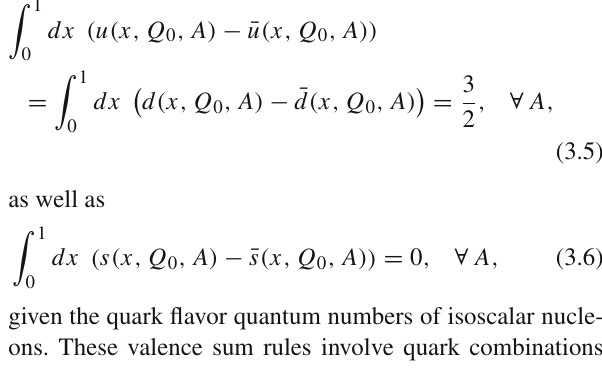
with the settings of the baseline proton fit, chosen to be the NNPDF3.1 set with perturbative